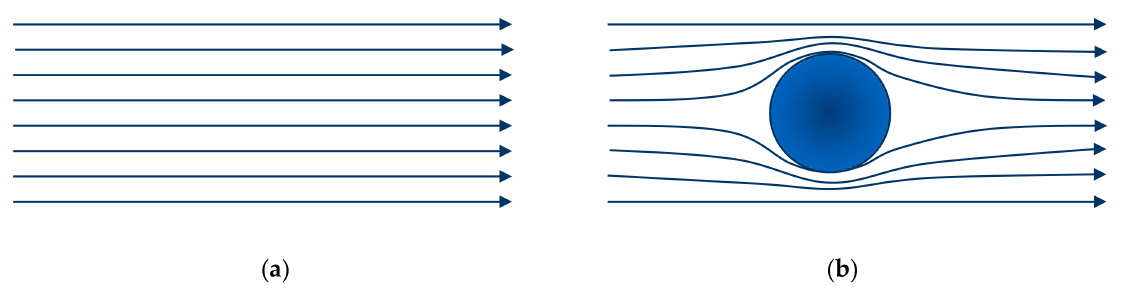
Figure 1. ( a ) Laminar flow field in a liquid medium. ( b ) Distortion in the laminar flow field due to the presence of a single spherical